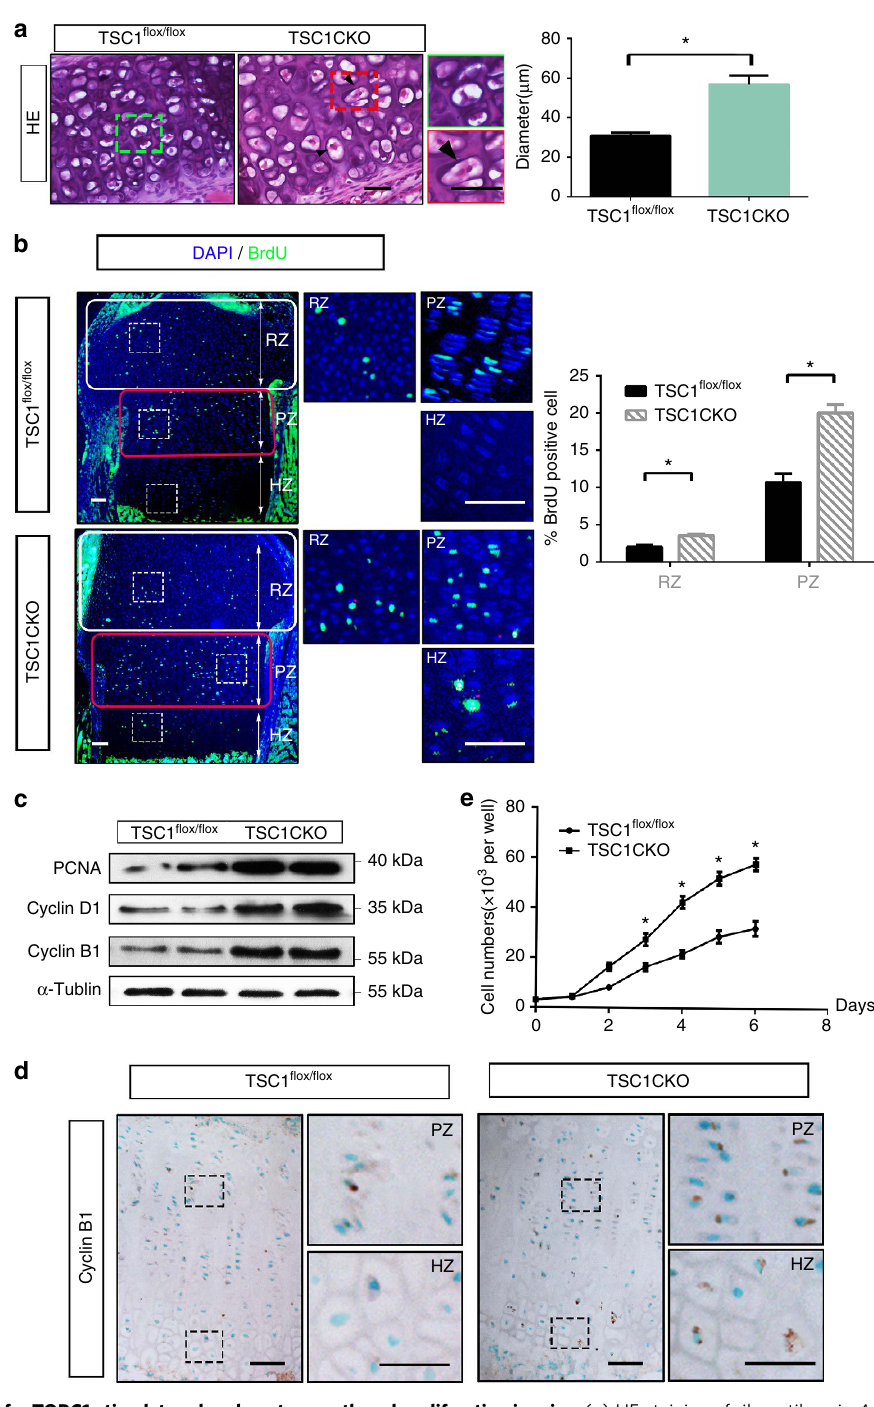
Figure 4 | Activation of mTORC1 stimulates chondrocyte growth and proliferation in mice. ( a ) HE staining of rib cartilage in 4-week-old TSC1CKO mice and control mice. Boxed areas on the right represent higher magnification. Triangles indicate chondrocytes under mitosis. Quantification of chondrocyte size. Scale bar, 100 m m. ( b ) BrdU labelling of chondrocytes in tibia of P0 TSC1CKO and control mice. Boxed areas on the right represent RZ, PZ and HZ at a higher magnification. Rounded rectangles represent the counted regions in quantification of BrdU-positive cells. Scale bar, 100 m m. Quantification of BrdU labelling in chondrocytes. BrdU-positive cells are counted in white rounded rectangles (RZ) and red rounded rectangles (PZ). Student’s t- test, * P o 0.05. n Z 3 mice for each genotype; error bars indicate s.d. ( c ) Western blot analysis showing the expression of PCNA, Cyclin D1 and Cyclin B1 in primary cultured chondrocytes isolated from TSC1 flox/flox and TSC1CKO mice at P0. ( d ) Immunofluorescence analysis of Cyclin B1 expression in TSC1CKO and control mouse tibia tissue at 3 weeks. Scale bar, 100 m m. ( e ) CCK8 proliferation assay of primary chondrocytes isolated from TSC1 flox/flox and TSC1CKO mice. Student’s t -test, * P o 0.05, n Z 3; Error bars indicate